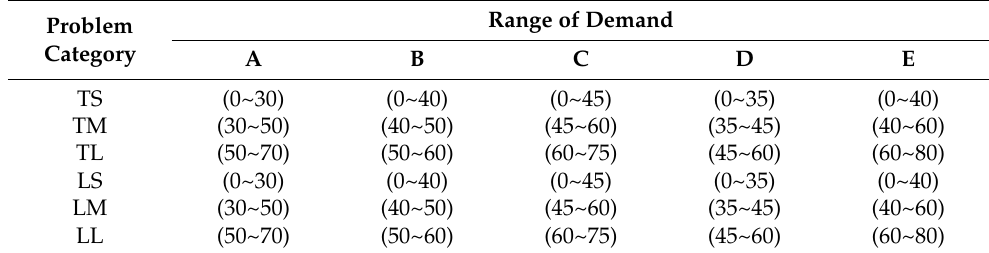
Table 1. Problem types based on demand and due